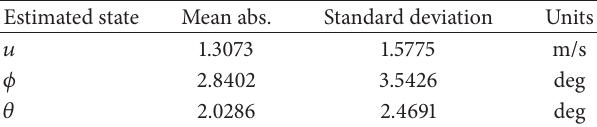
Table 5: Simplified formulation error statistics for Flight